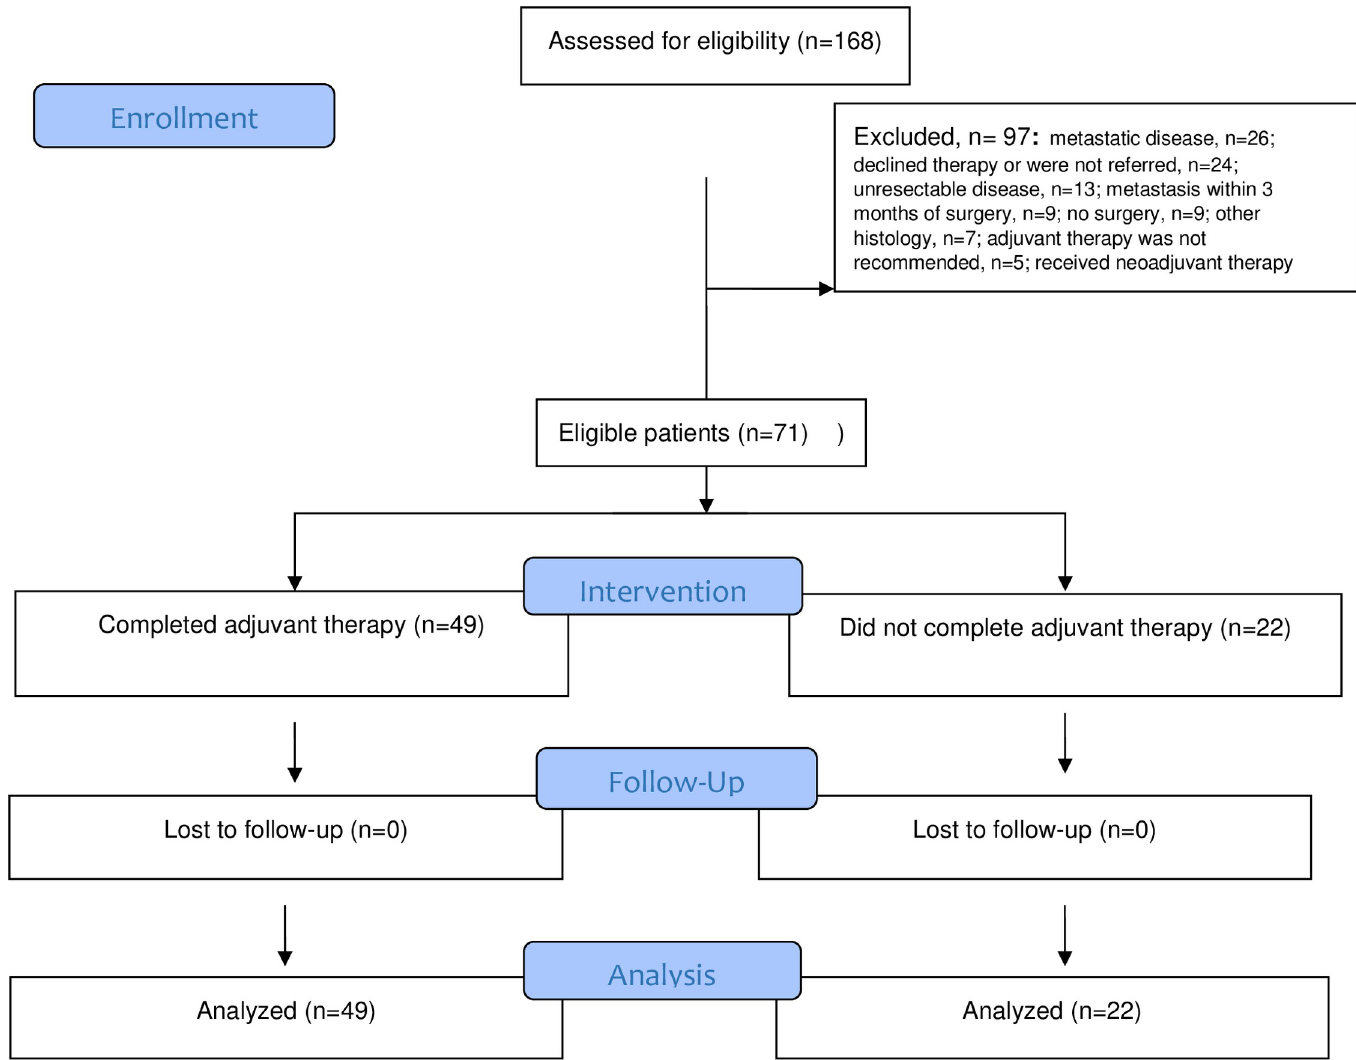
Fig 1. Flow diagram of eligible patients with pancreatic cancer eligible for the